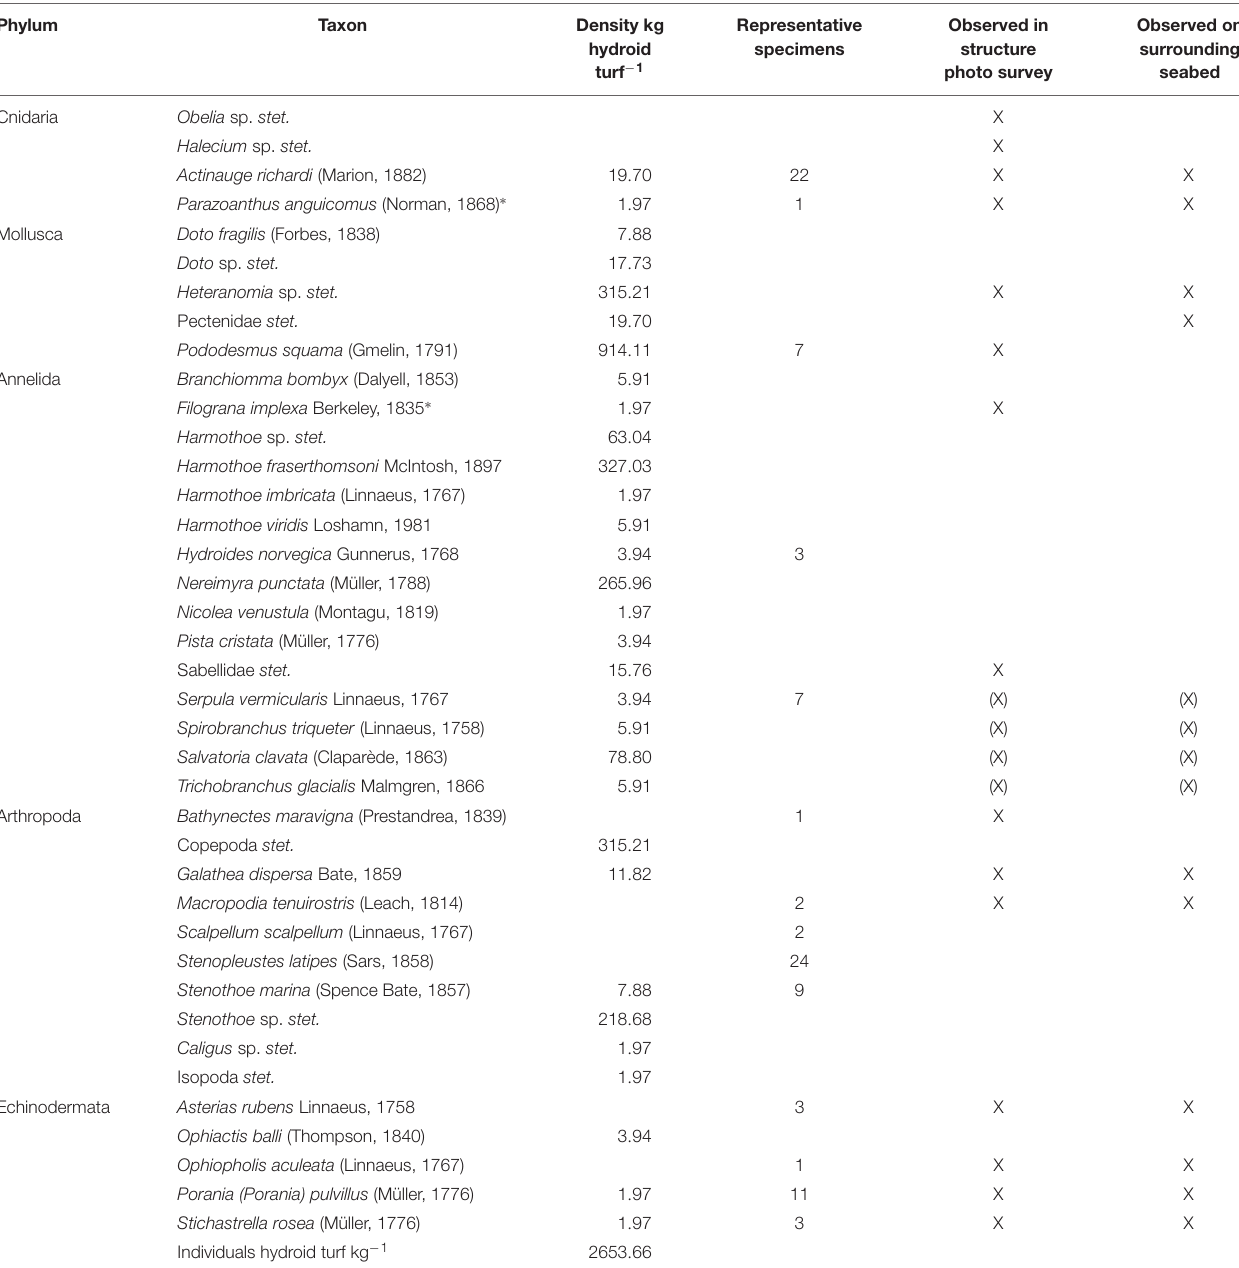
TABLE 6 | Species list: fauna associated with hydroid turf. Phylum Taxon Density kg